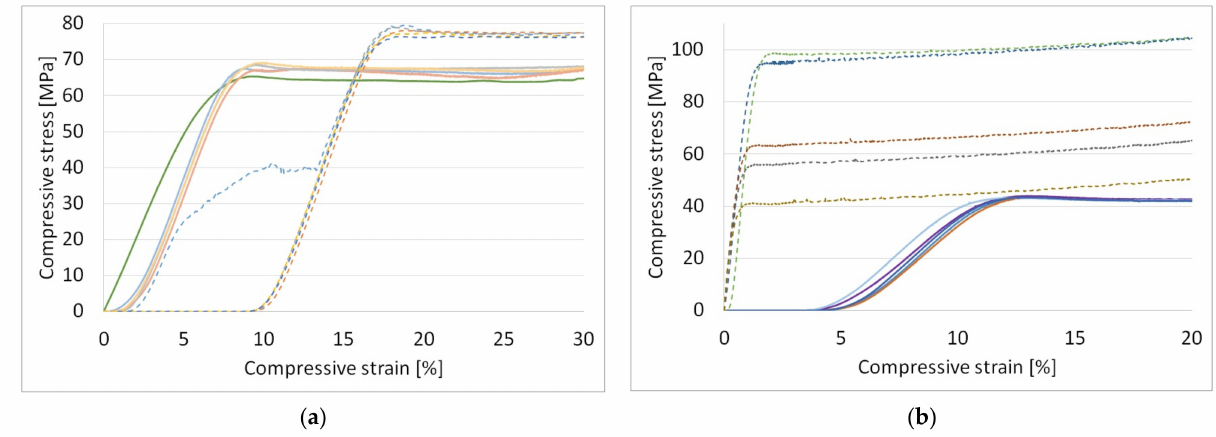
Figure 6. Compressive strength testing results: ( a ) PLA UV-C exposed group (solid) and control group (dashed); ( b ) PETG UV-C exposed group (solid) and control group (dashed).